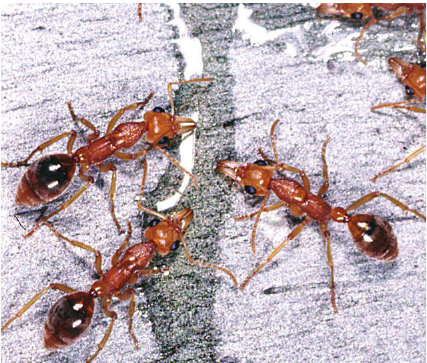
Figure 2: Nothomyrmecia macrops Clark: foraging workers feeding nocturnally at experimental honey bait on host Eucalyptus tree trunk. These ants accumulated as individuals, without collaborative interaction. Note the progressively distended gasters from right to left. (Poochera, SA, R. W. Taylor).